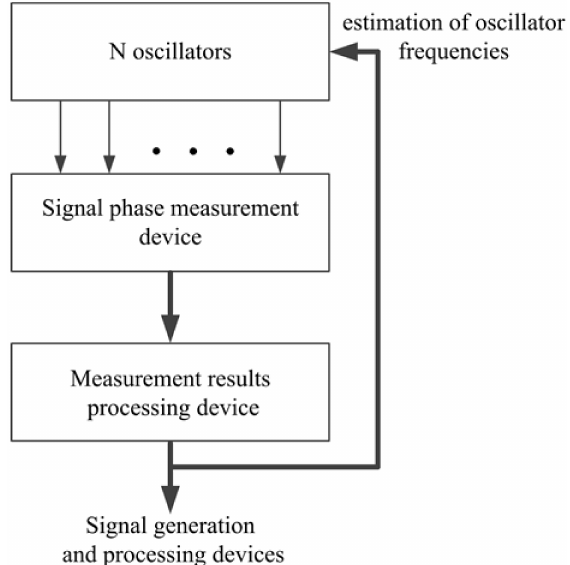
Figure 1. Block diagram of a system for estimating the frequency of oscillator signals based on the implementation of the properties of synergy and